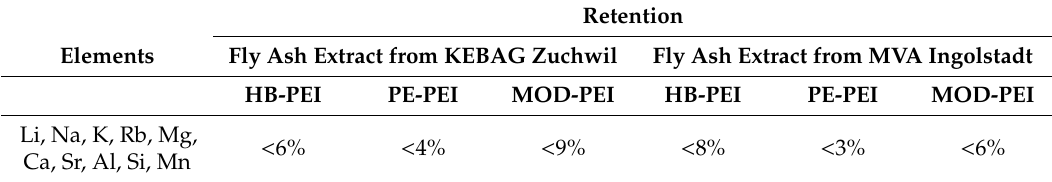
Table 2. Retention of Li(I), Na(I), K(I), Rb(I), Mg(II), Ca(II), Sr(II), Al(III), Si(IV), and Mn(II) using fly ash extracts from KEBAG Zuchwil and MVA Ingolstadt and HB-PEI, PE-PEI, and MOD-PEI polymers. Retention Elements Fly Ash Extract from KEBAG